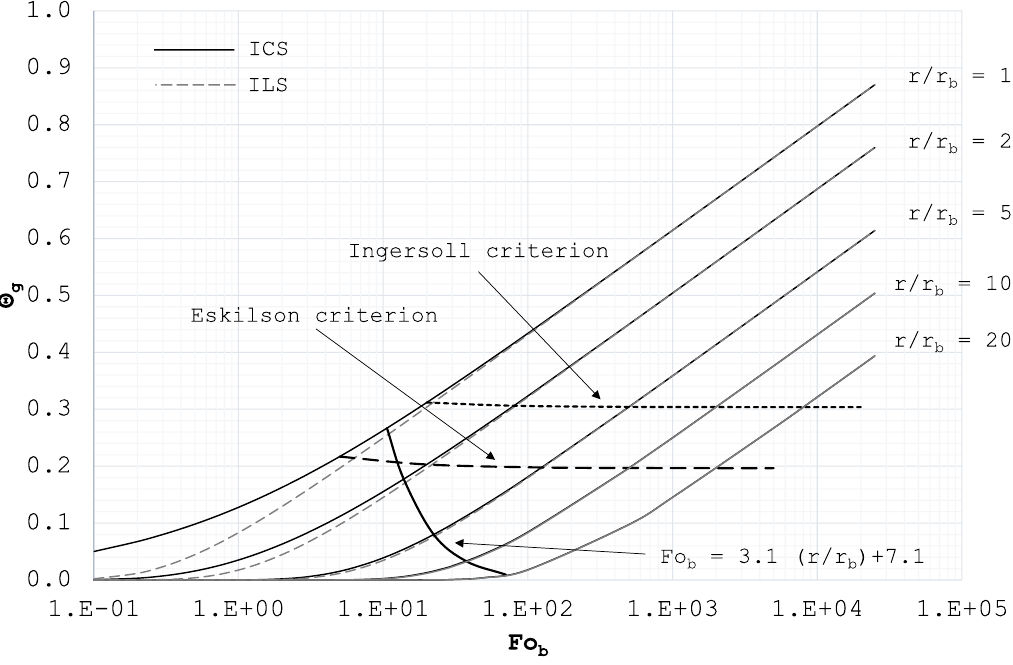
Figure 4. Dimensionless temperature, Θ g , given by the ILS (gray lines) and ICS models (black lines). The expression Fo b ≥ 3.1 ( r / r b ) + 7.1 evaluates the maximum Fo b beyond which the relative deviation between ICS and ILS models is lower than 5